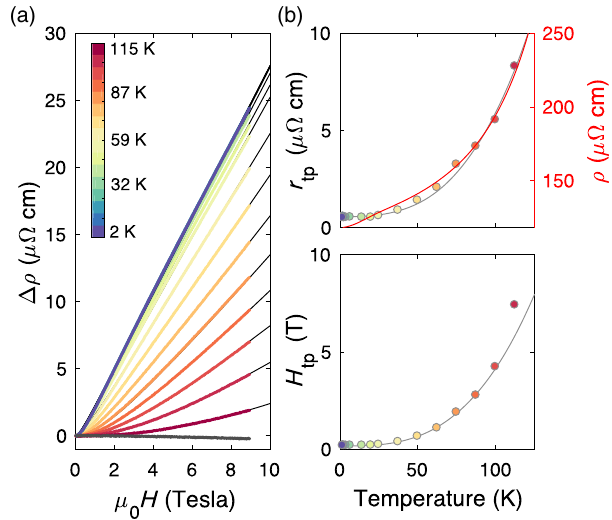
FIG. 2. Transport in BaFe 2 As 2 and magnetoresistance model based on turning points. (a) Isothermal magnetoresistance at various temperatures. Black lines are fits to the turning-point model given by Eq. (3). (b) Model parameters extracted from the fits; error bars are smaller than the data points. The grey lines show that both parameters vary with T 3 with a finite offset. The red line shows that the zero-field resistivity similarly varies approximately with T 3 , suggesting that the MR parameters vary with the scattering